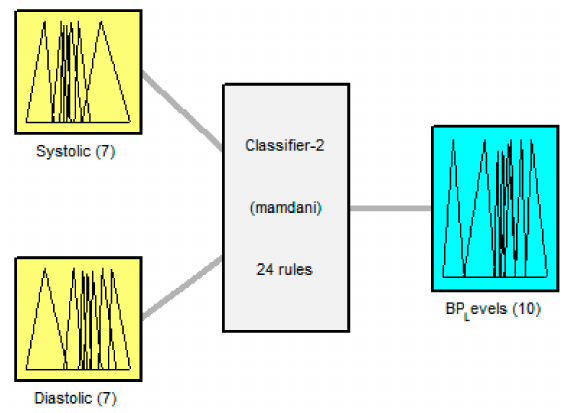
Figure 7. Structure of the fuzzy logic classifier 2.